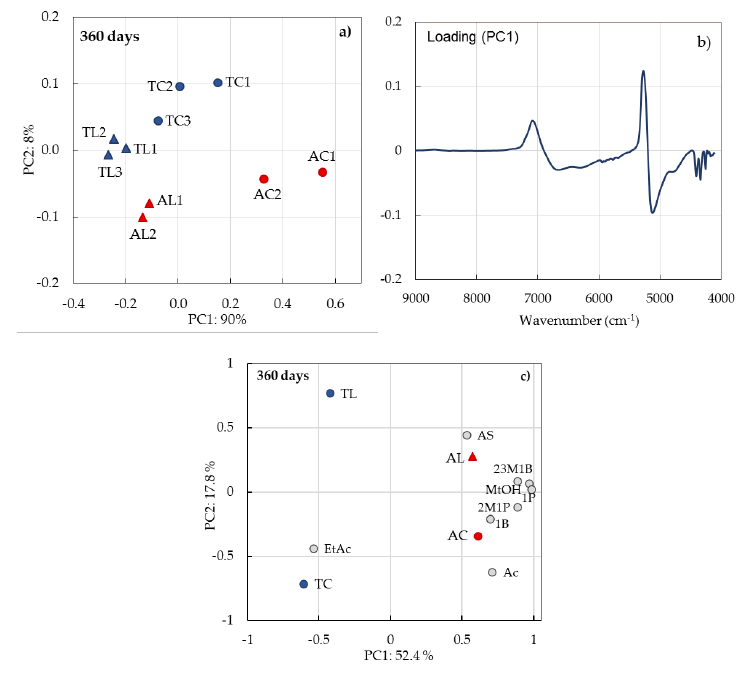
Figure 5. Principal component analysis of wine spirits aged by the traditional and alternative technologies with chestnut and oak wood for 360 days for: ( a ) scores of NIR spectral information; ( b ) loadings of NIR spectral information; ( c ) standardised scores and loadings of analytical parameters measured. TC—aged in 250 L chestnut new barrels; TL—aged in 250 L oak new barrels; AC—aged in 1000 L stainless steel tanks with chestnut wood staves and micro-oxygenation; AL—aged in 1000 L stainless steel tanks with oak wood staves and micro-oxygenation.AS—alcohol strength (%); MtOH—methanol (g / mL); Ac—acetaldehyde (mg / mL); EtAc—ethyl acetate (mg /